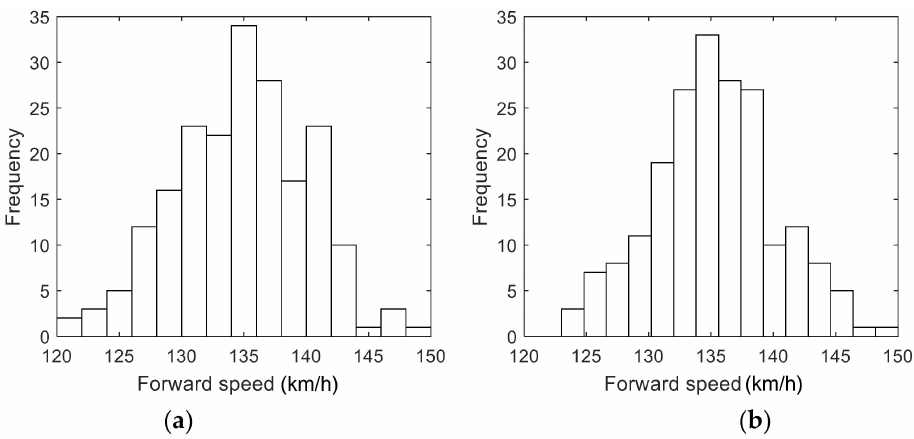
Figure 12. Train speeds, ( a ) healthy case, ( b ) damaged